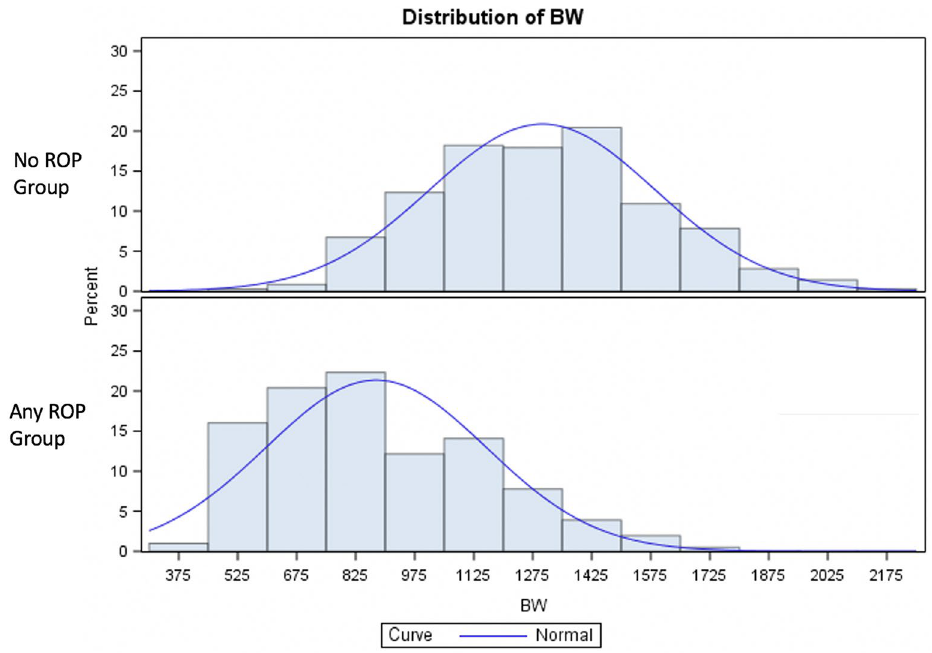
Figure 2. Distribution of birth weights in NoROP preterm babies and in all ROP group (Group 1 and Group 2). ANOVA test, p < 0.0001. Birth weights were adjusted for gestational age. BW birth weight.